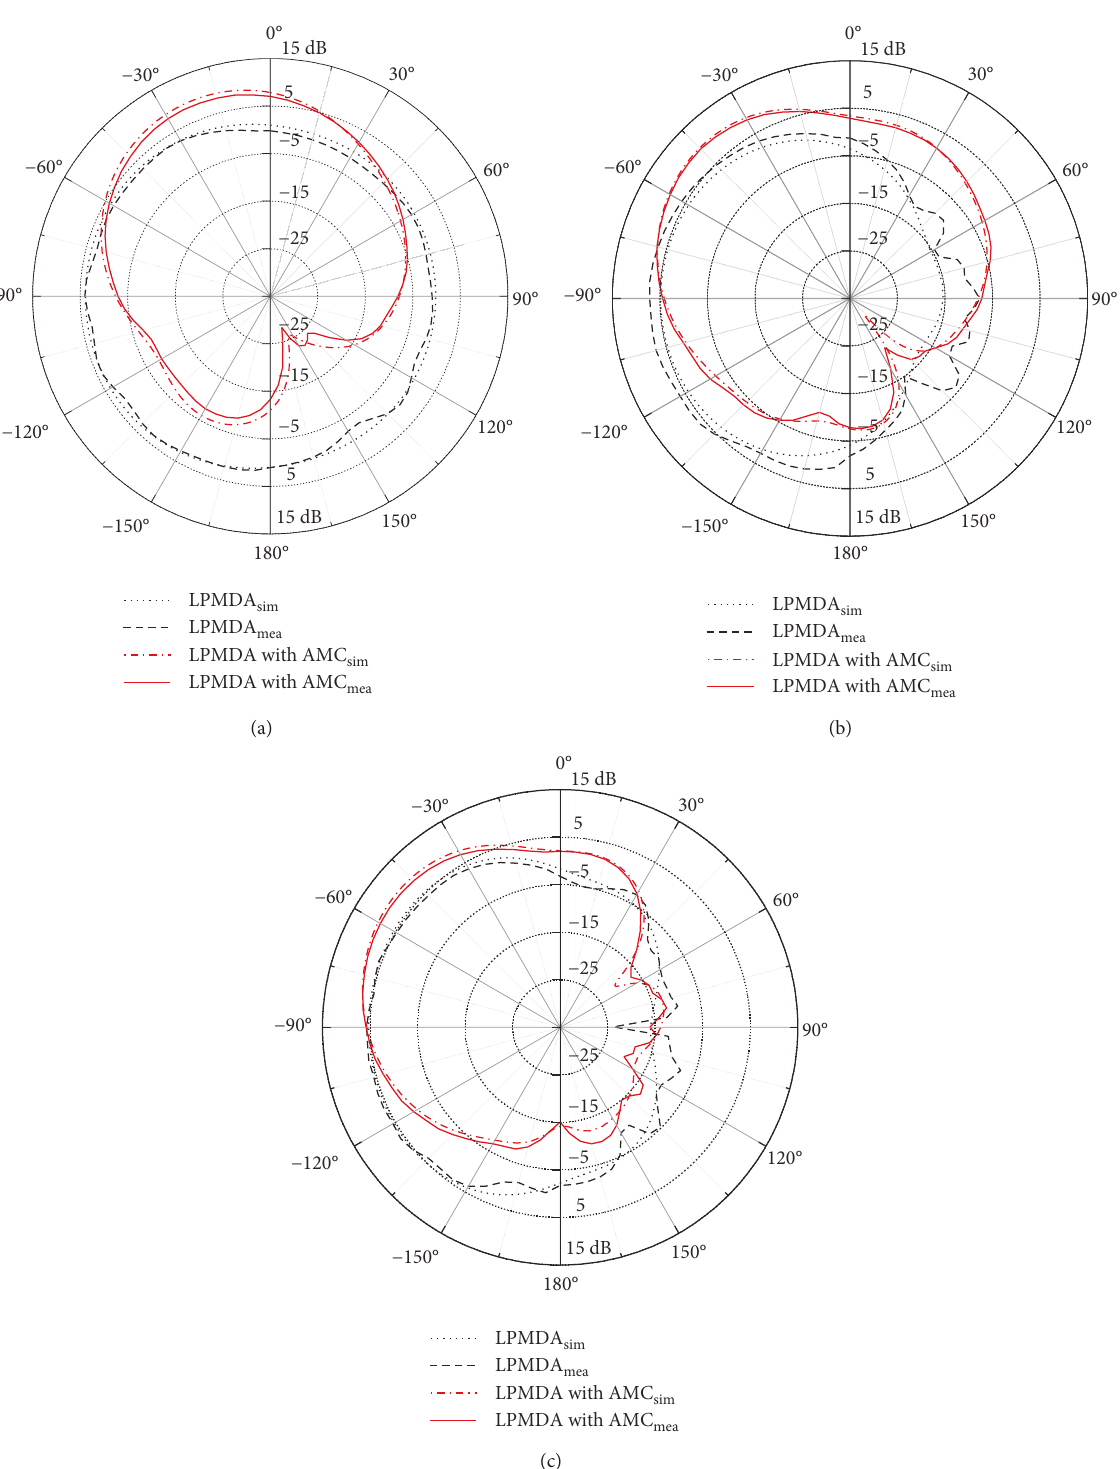
Figure 13: Simulated and measured radiation patterns on the yz -plane at (a) 1 GHz, (b) 1.3 GHz, and (c)